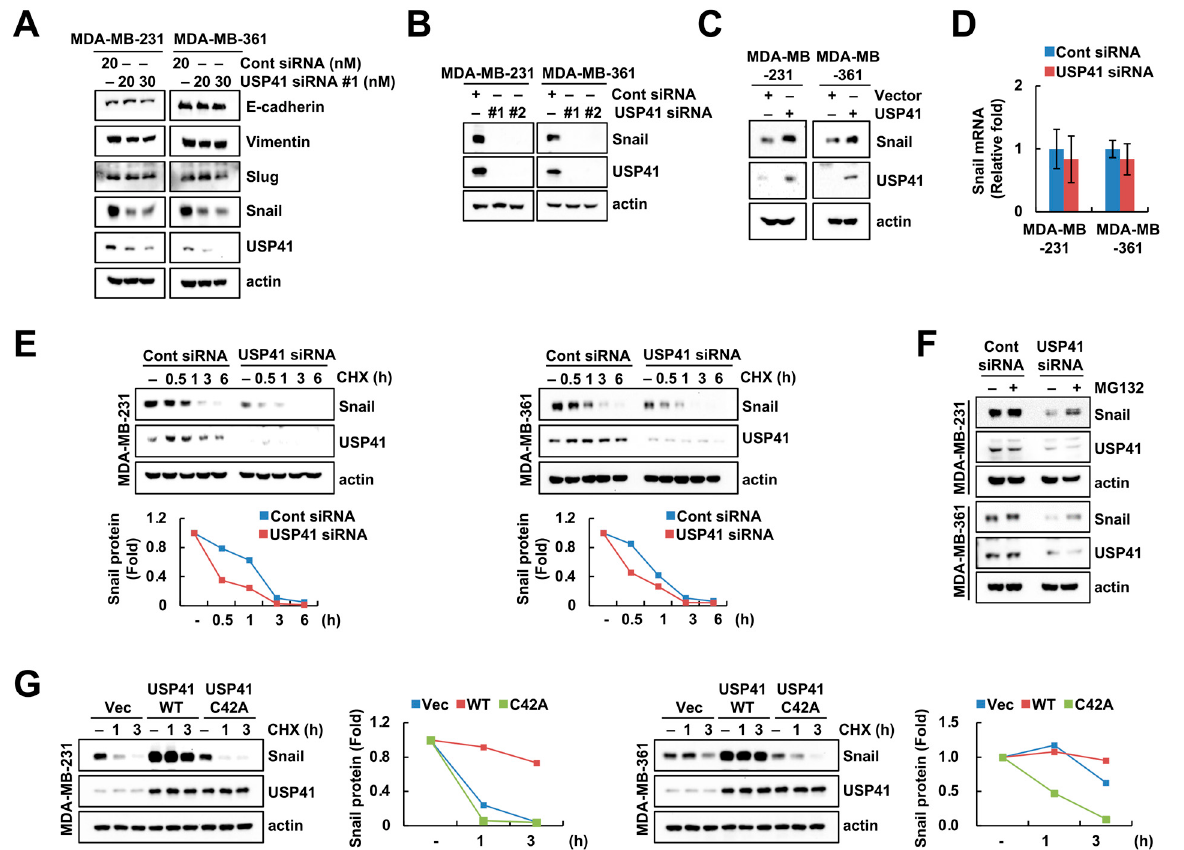
Figure 4. Depletion of USP41 downregulates Snail expression at the post ‐ translational level. ( A – D ) MDA ‐ MB ‐ 231 and MDA ‐ MB ‐ 361 cells were transfected using Cont siRNA and USP41 siRNA ( A , B , D ), or vector and USP41 plasmid ( C ) for 48 h. ( E ) MDA ‐ MB ‐ 231 and MDA ‐ MB ‐ 361 cells were transfected with Cont or USP41 siRNA, and treated with 20 μ g/mL cycloheximide (CHX) for the indicated time points. ( F ) MDA ‐ MB ‐ 231 and MDA ‐ MB ‐ 361 cells were transfected with Cont or USP41 siRNA, and treated with 0.25 μ M MG132 for 12 h. ( G ) MDA ‐ MB ‐ 231 and MDA ‐ MB ‐ 361 cells were transfected with vector, USP41 wild ‐ type (WT) or mutant (C42A), and treated with 20 μ g/mL CHX for the indicated time points. Protein ( A – C , E – G ) and mRNA expression ( D ) were determined by Western blotting and qPCR, respectively. The density of Snail protein was quantified by Image J program.